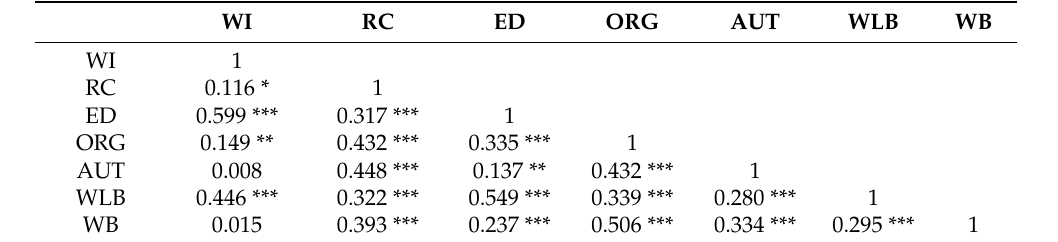
Table 3. Correlations between variables.